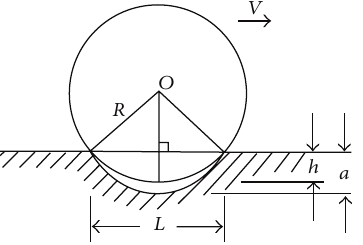
Figure 2: Schematic of contact situation between wheel and